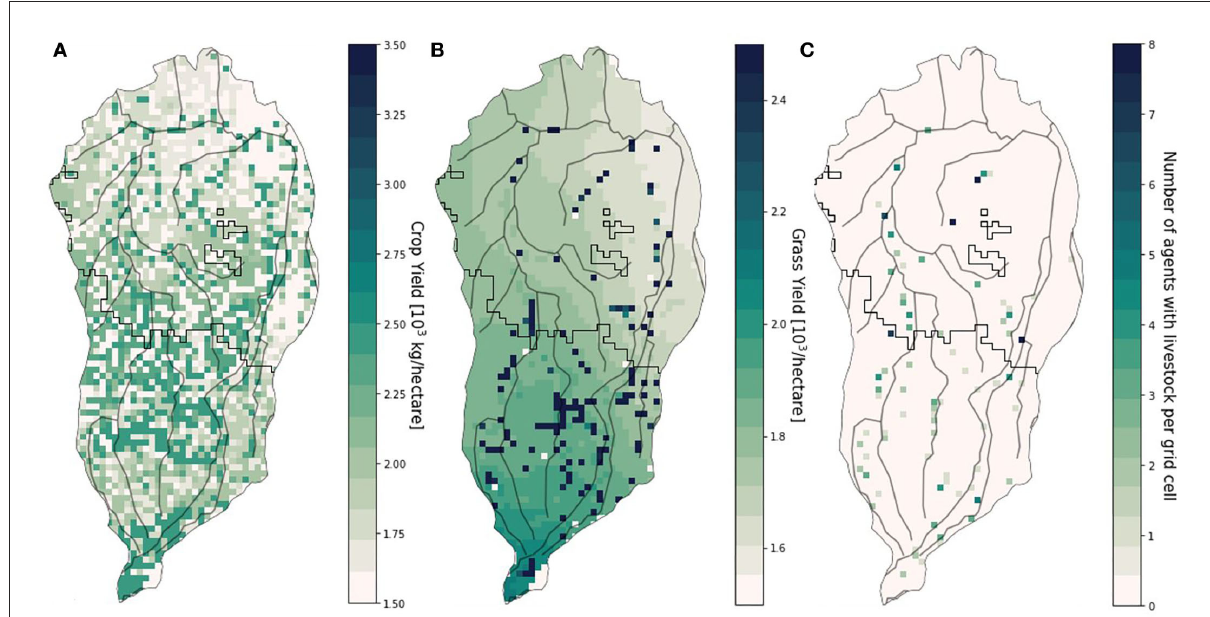
FIGURE5 Crop yield of rainfed maize in OND season 2010 (A) , grass yield in JJA dry season of 2011 (B) , and migration of livestock (C) , expressed as the number of migrating agents with livestock in a grid cell in